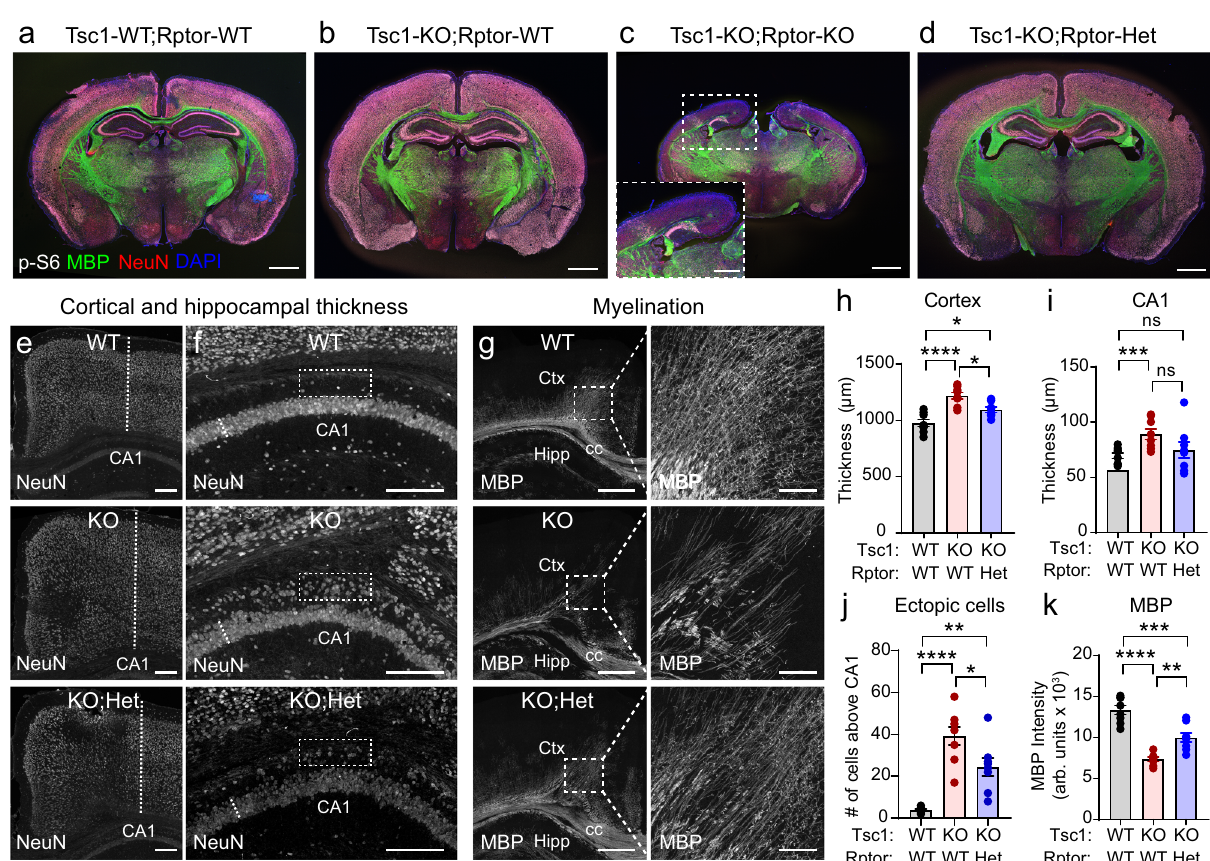
Fig. 5 | Removalofone copy of Rptor improves forebrain developmentinTsc1- cKO mice. a – d Representative coronal brain sections from mice of the indicated genotypes. Immunostaining for p-S6 Ser240/244 is in gray, myelin basic protein (MBP)isingreen, NeuNisinred andDAPI-labeled nucleiareinblue.Scalebars= 1 mm. In panel ( c ), inset shows zoomed-in image of the cortex and hippocampal region(scalebar=500 μ m).Thisexperimentwasreplicated8timespergenotype. e Representative images of the cortex with NeuN immunostaining. Dashed lines denote the measurement of cortical thickness. WT = Tsc1-WT;Rptor-WT, KO = Tsc1-KO;Rptor-WT, KO;Het = Tsc1-KO;Rptor-Het. Scale bars = 500 μ m. f Representative images of the hippocampal CA1 region with NeuN immunos- taining. Dashed lines denote the measurement of CA1 thickness. Boxed regions highlighttheareaabovethe CA1thatcontainsectopicp-S6expressingneuronsin Tsc1-KO;Rptor-WT mice (quanti fi ed in panel ( j )). Scale bars = 250 μ m. g Representative images of MBP immunostaining in the cortex (Ctx) & dorsal hippocampus(Hipp).cc=corpuscallosum.Scalebars=500 μ m.Rightpanelsshow higher magni fi cation of the boxed regions in the cortex. Scale bars = 100 μ m.